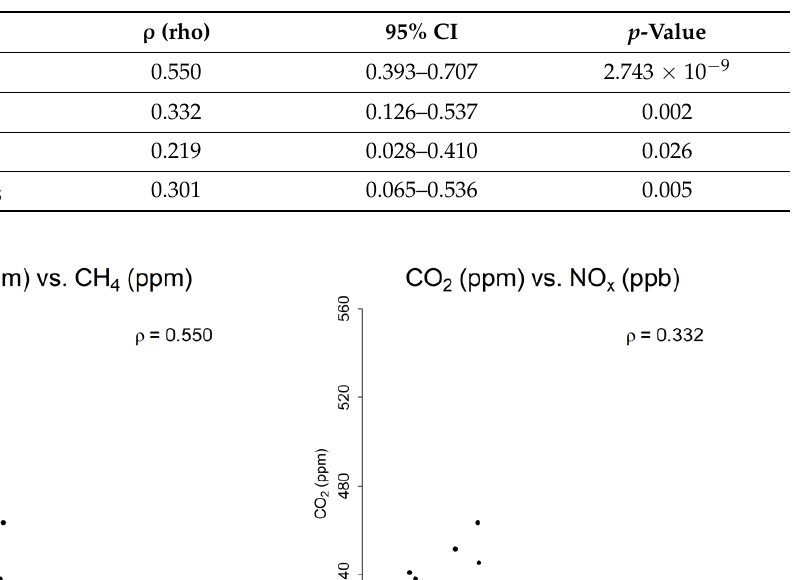
Table 5. Bonneville Phase 1 Spearman correlation test results for van pollutant readings.